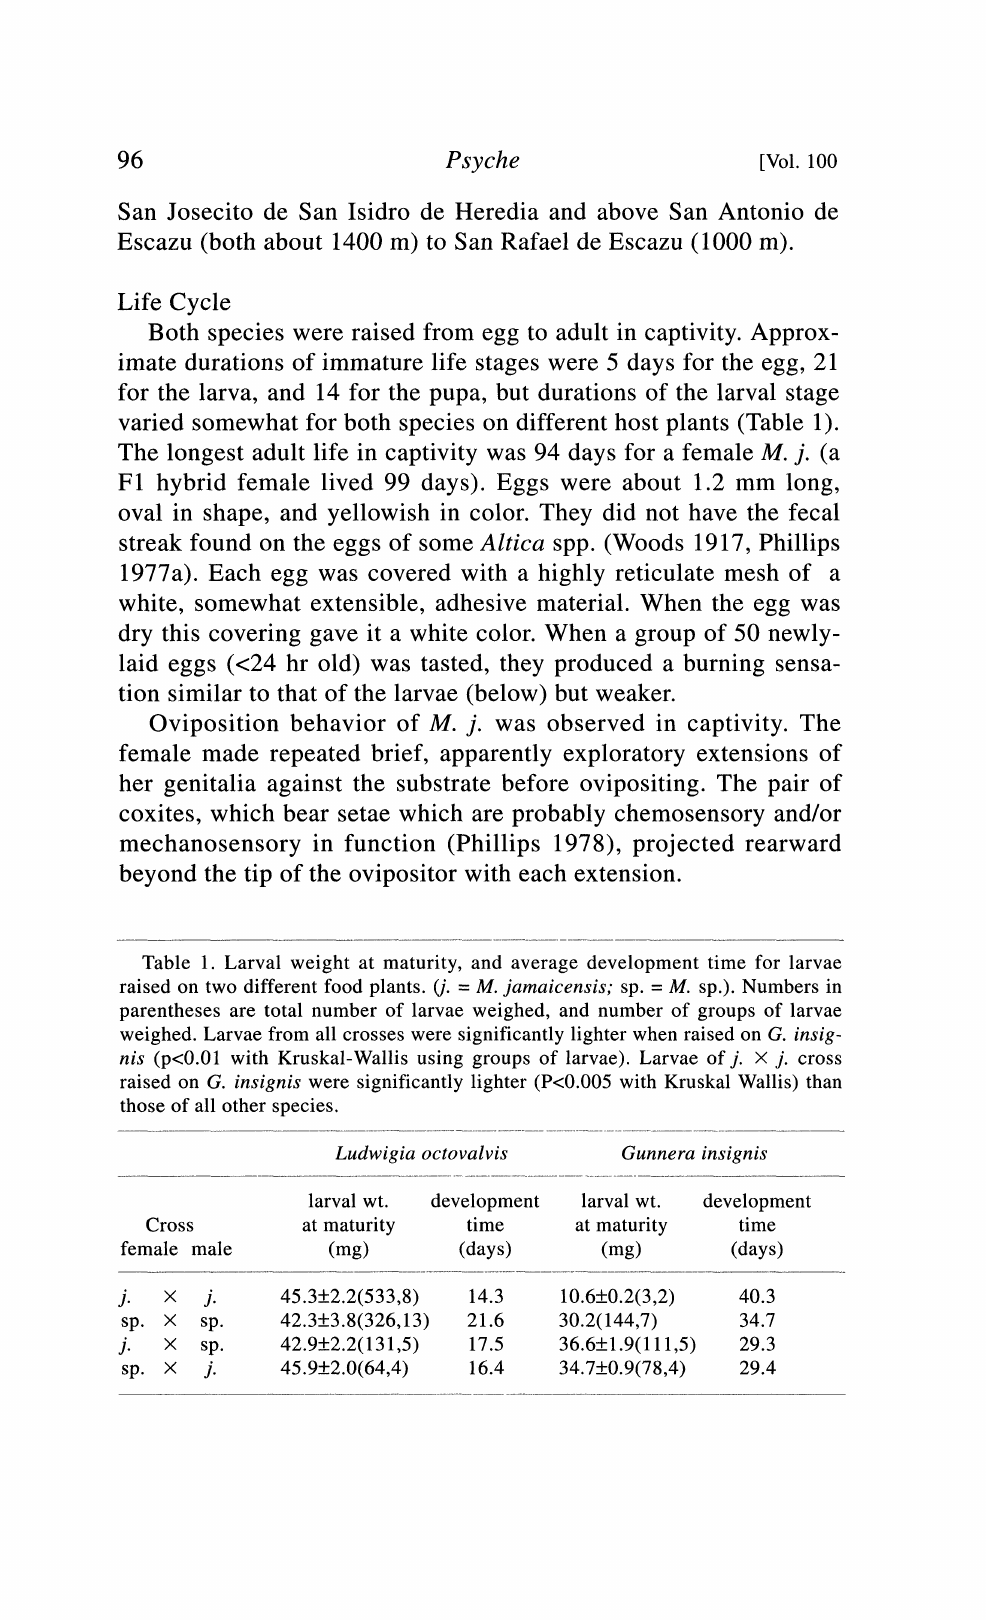
Table 1. Larval weight at maturity, and average development time for larvae raised on two different food plants. (j. M. jamaicensis;